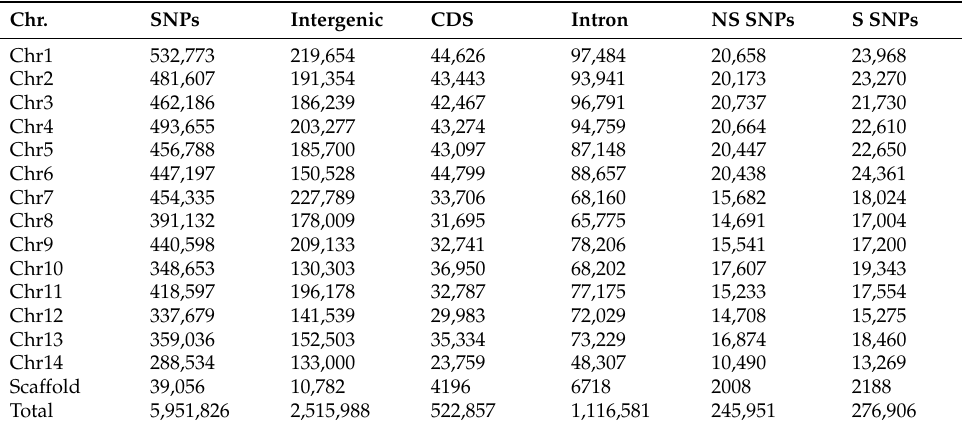
Table 4. Distribution of SNPs in ramie genome.